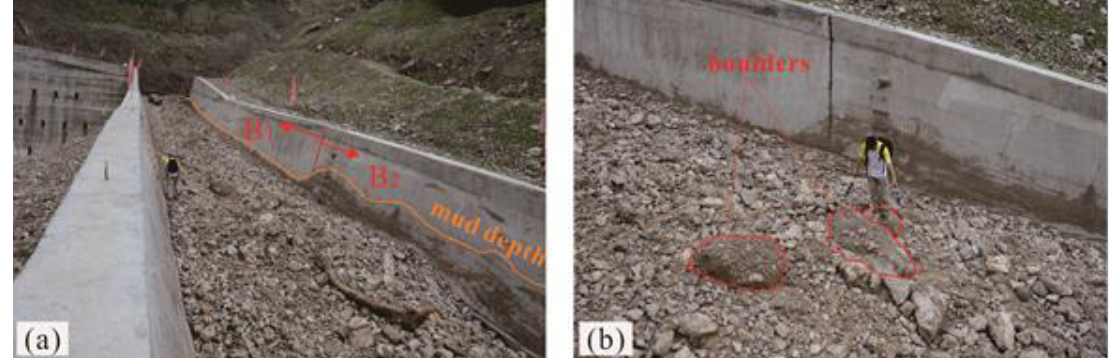
Figure 11. Photos of mud marks and siltation from the debris flow that occurred on 26 July 2012, in the ED section. ( a ) The mud depth of the 26 July 2012 debris flow in sec. B 1 and B 2 (ED sec.); ( b ) boulders deposited in the ED section.